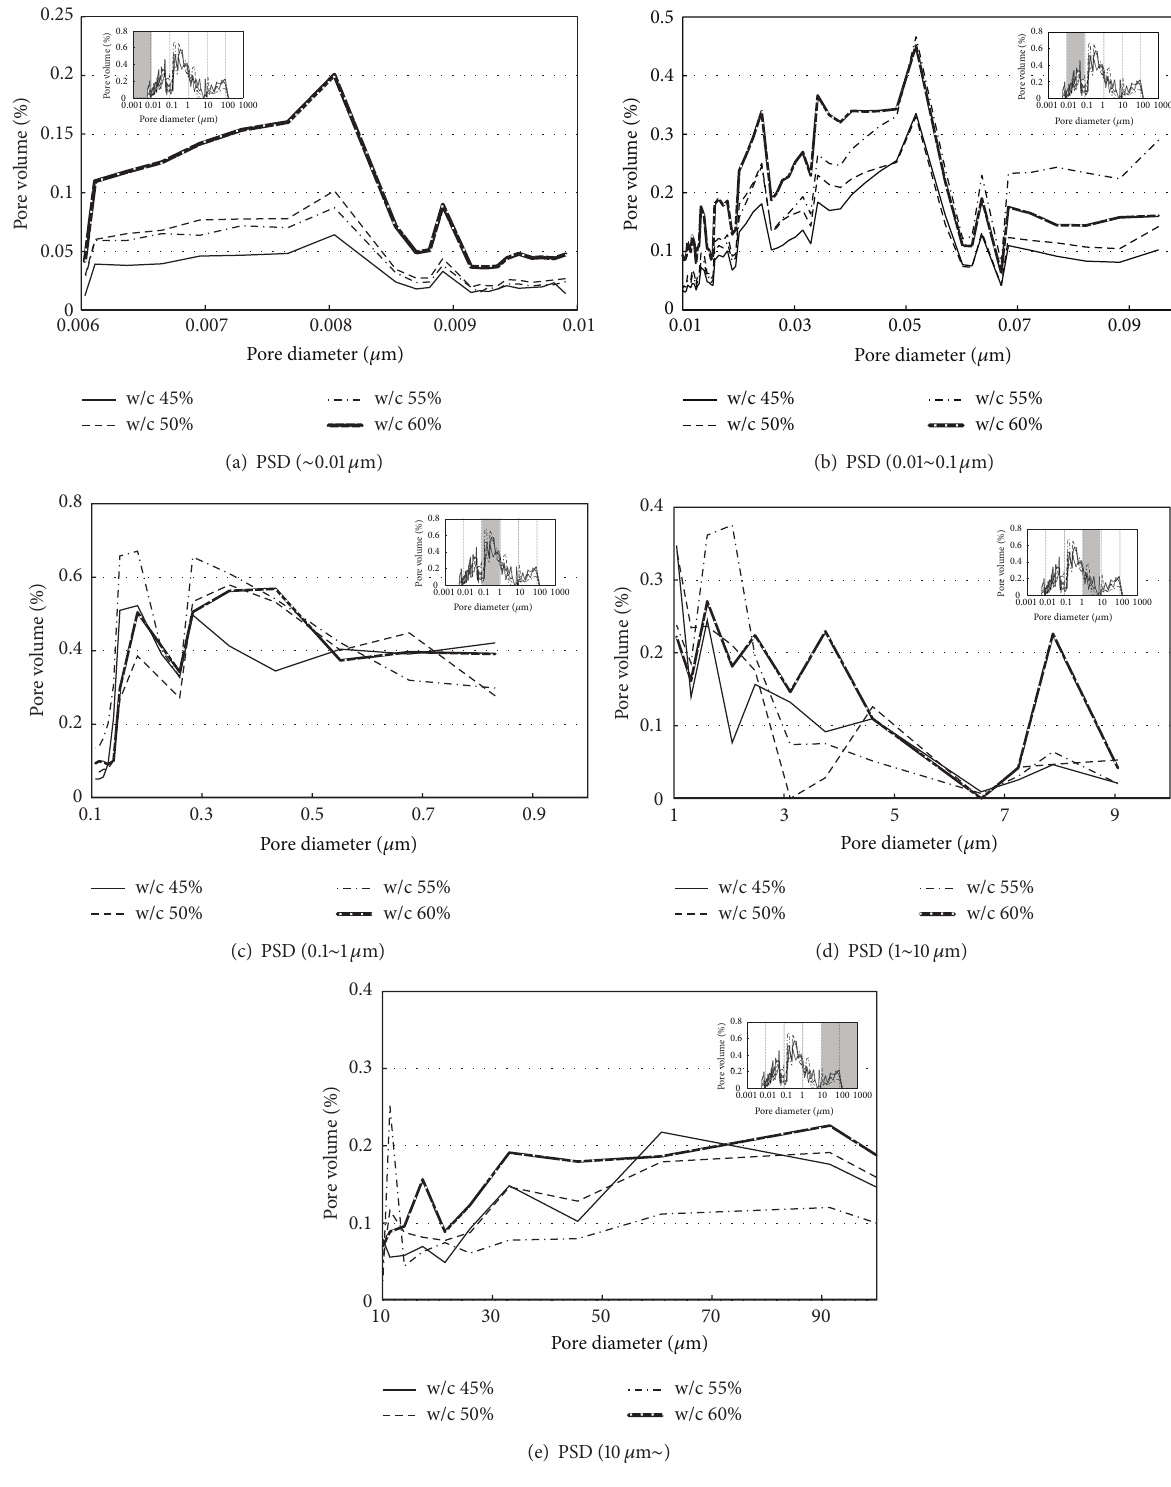
Figure 9: PSD in different pore